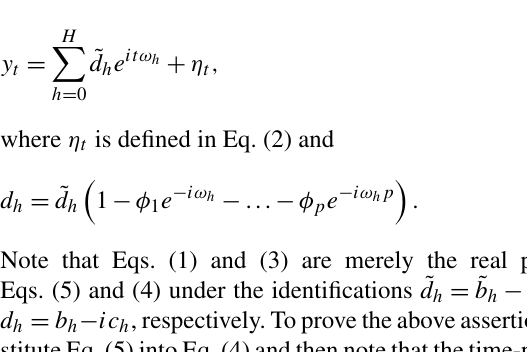
Figure 1. The periodic response of a noise-free AR(1) model to si- nusoidal forcing for AR parameters φ = 0, 0.5, and 0.8. The forcing is shown by the black curve, which is equivalent to the response for φ =